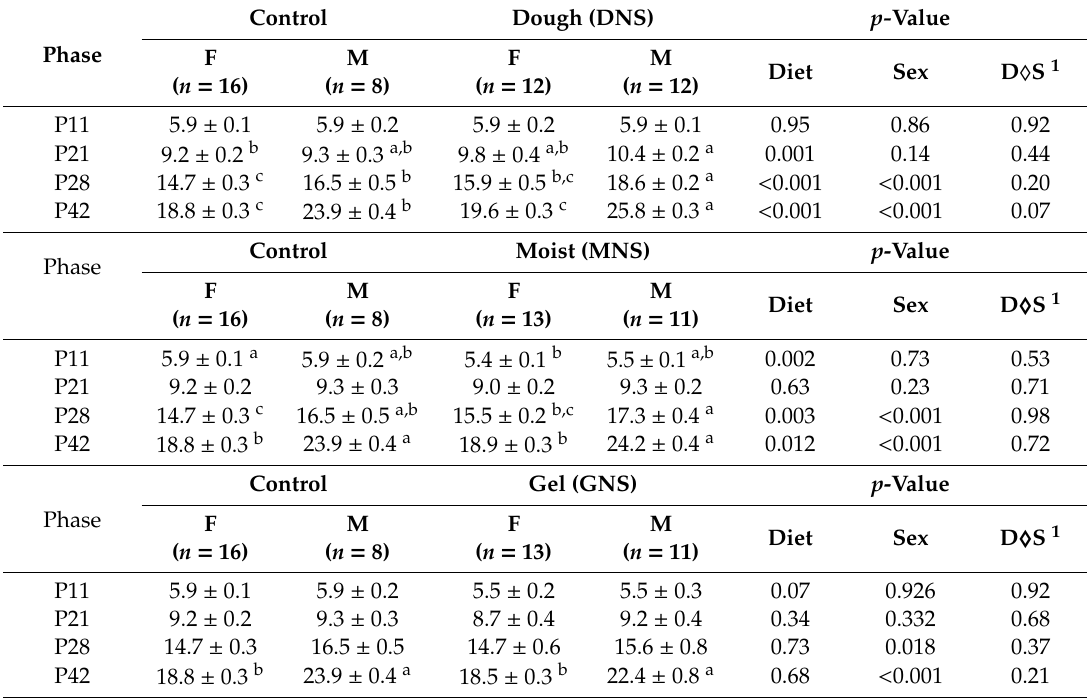
Table 2. Change in weight with dietary supplementation and / or